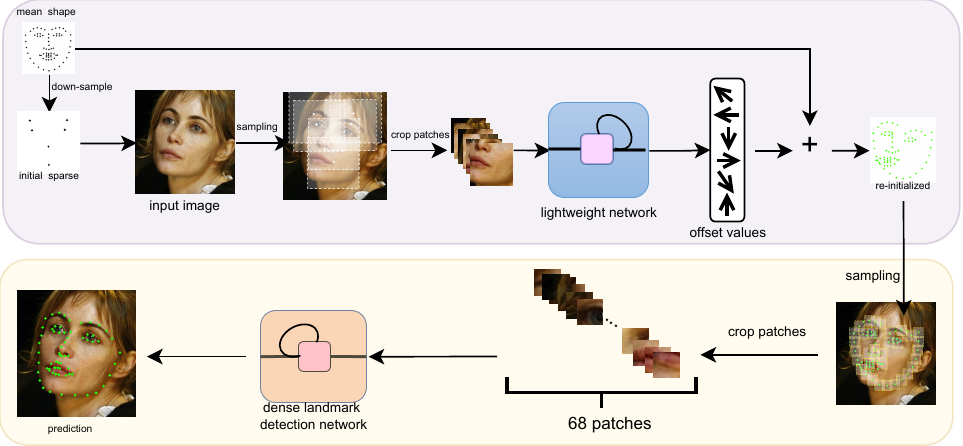
Figure 2. Overall architecture of the proposed network. It consists of two stages: the patch resampling stage ( the first row ) and the relation reasoning stage ( the second row ). The downsample operation in the first row averages the coordinates of the landmarks in each facial part according to the predefined indexes. The + operation in the first row adds the offset values of the corresponding sparse landmarks to the coordinates of all landmarks in each facial part of the mean